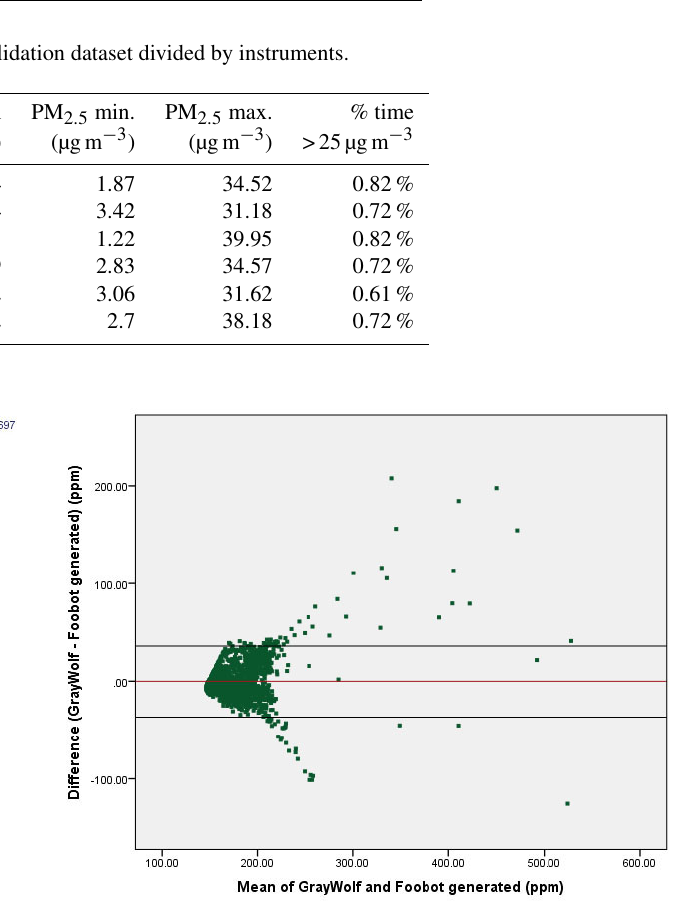
Figure 8. Scatter plot of the 5min t VOC concentration measured using the Foobot FBT0002100 and the GrayWolf TG-502 TVOC from the calibration dataset.